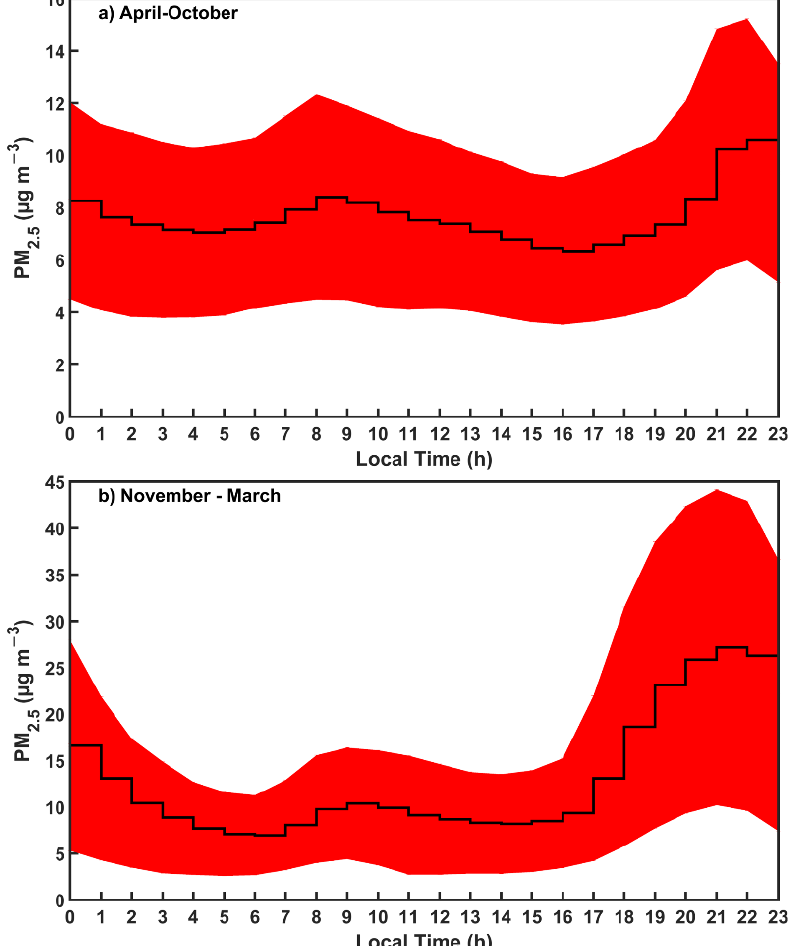
Figure 6. Average diurnal profile of PM 2 . 5 for all measurement stations in the city of Patras, not including the two background stations, during the ( a ) warmer (April – October) and ( b ) colder (November – March) periods. The standard deviation of the mean concentration is also shown as a shaded area.